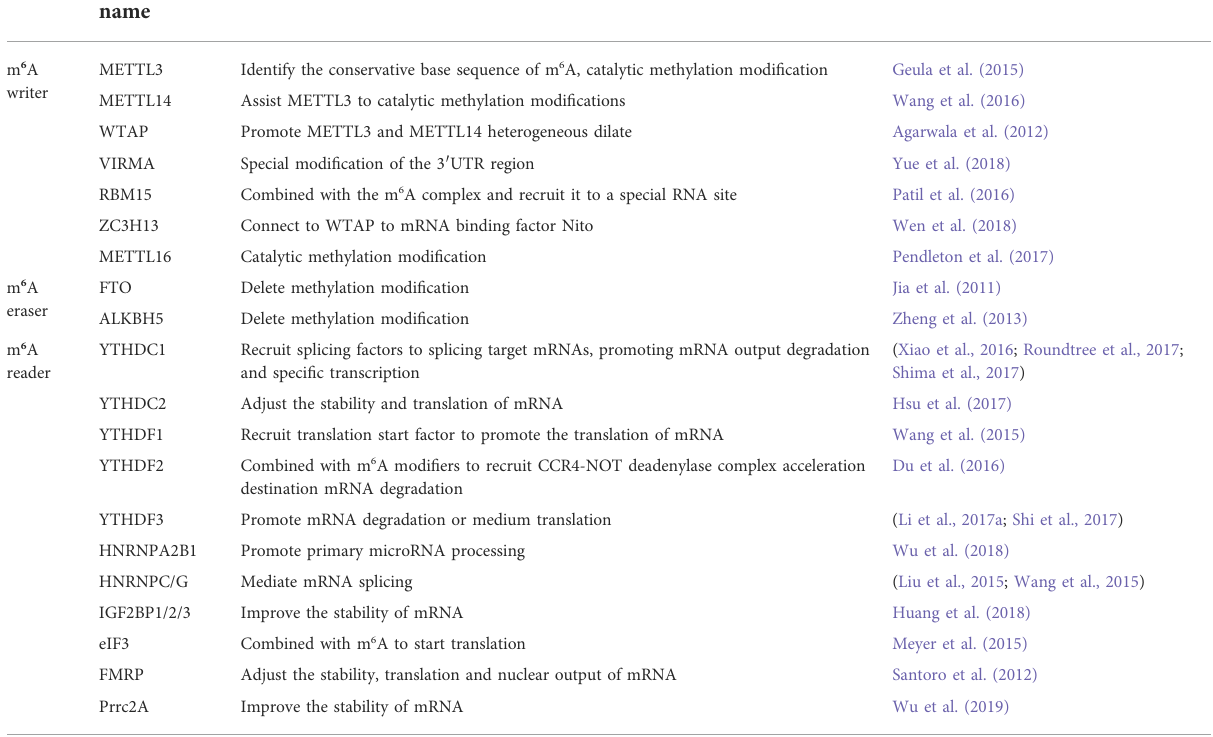
TABLE 1 Functions of m 6 A modi fi cation-related